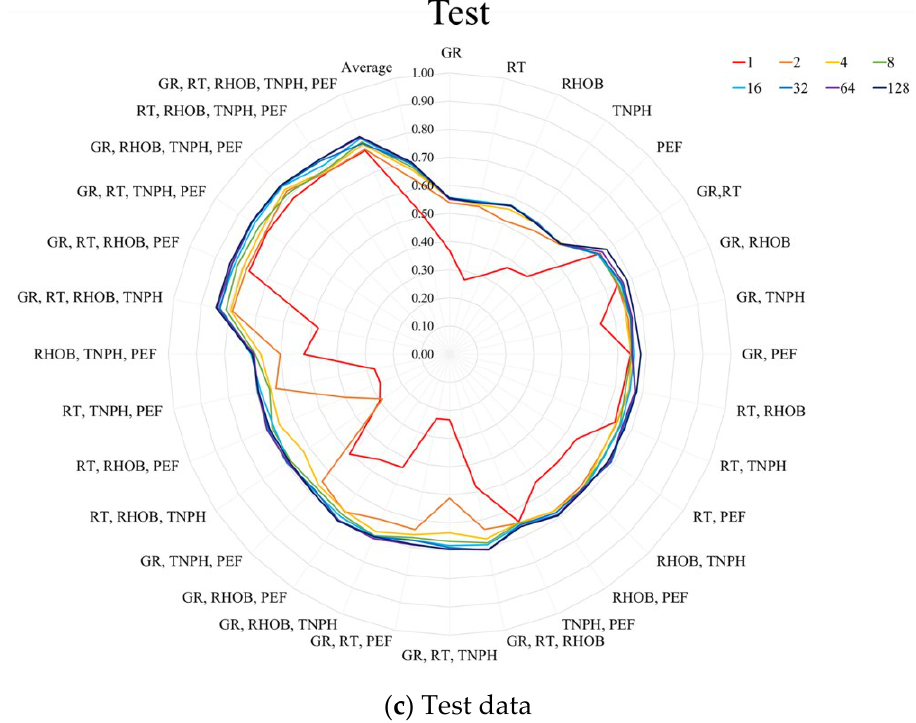
Figure 6. Comparison of the R 2 values for input combinations at various numbers of hidden neu- rons.